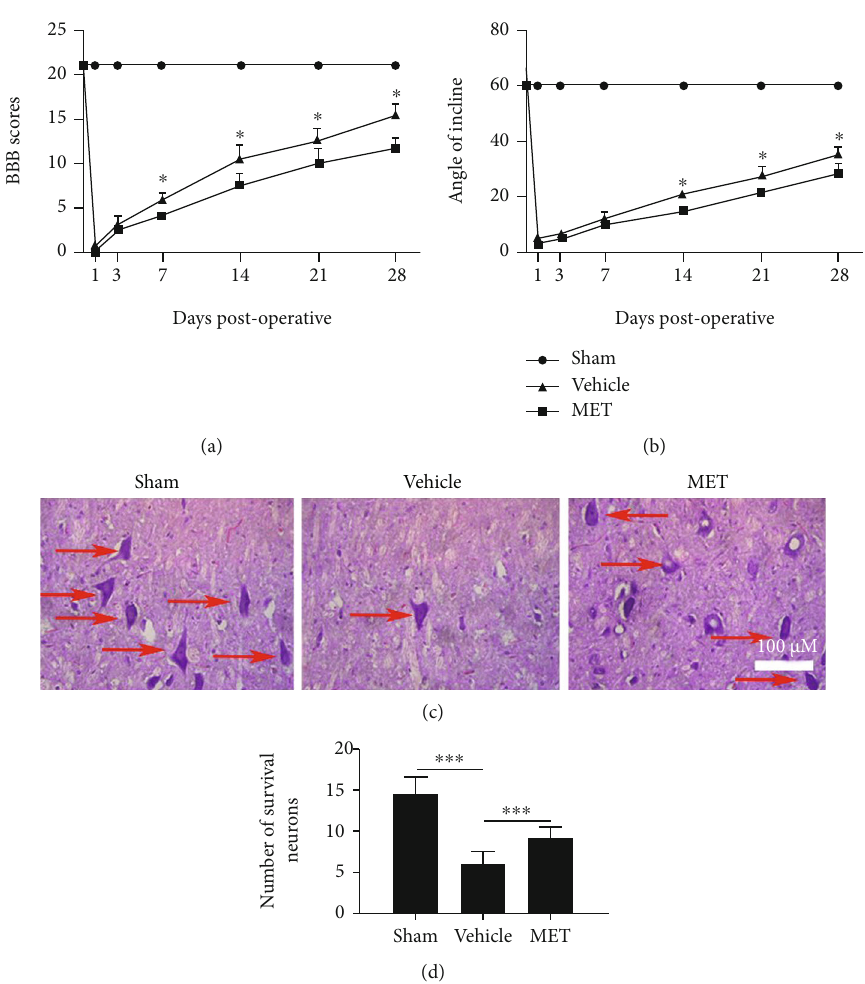
Figure 4: Metformin works on practical recuperation and diminishes the de fi ciency of neurons following SCI. (a) Scores of Basso, Beattie, and Bresnahan (BBB), ∗ P < 0 : 05 , n = 3 . (b) The inclined plane test, ∗ P < 0 : 05 , n = 3 . (c) HE staining at 28 days. Scale bars represent 100 μ m. (d) Counts of the number of front corner motor neurons. All data represent the mean ± SD , ∗∗∗ P < 0 : 001 , n = 3